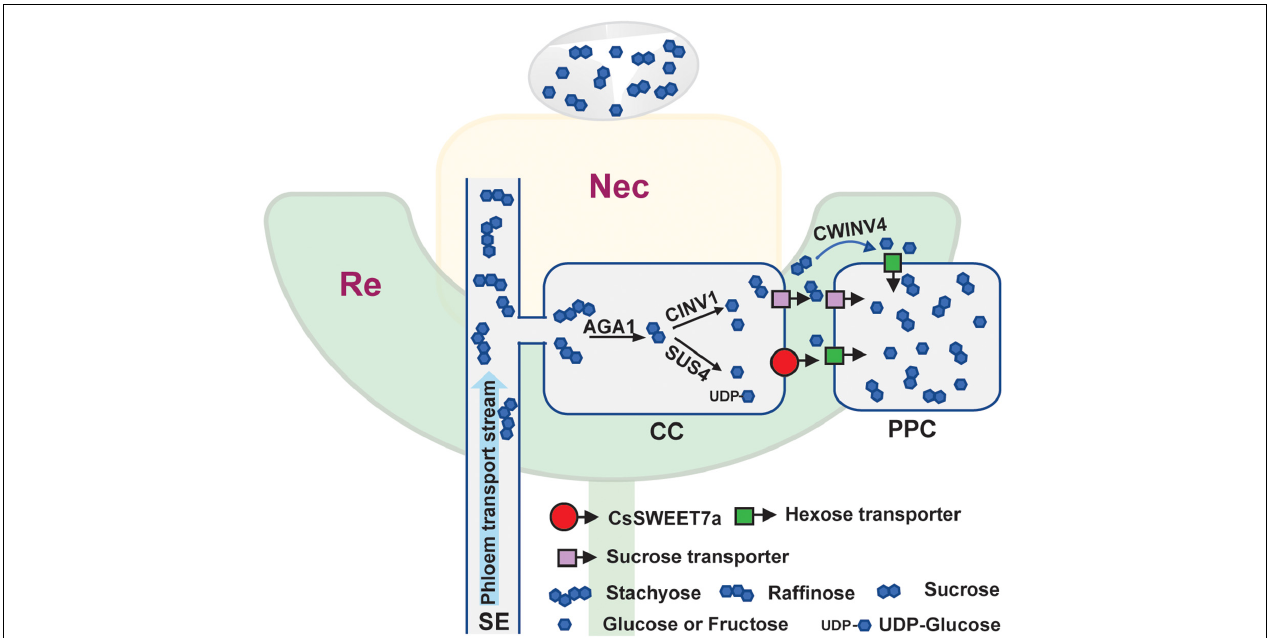
FIGURE 7 | Simplified model of CsSWEET7a function during phloem unloading in cucumber receptacle and nectary. The top light-yellow color region indicates the nectary (Nec) tissue, and the bottom light-green color region is the receptacle (Re) tissue. The droplet above the nectary represents the secreted nectar. A similar phloem unloading process is proposed in receptacle and nectary of male and female flowers. Photosynthetic sugars are transported to flower receptacles and nectary tissues via the phloem. As an RFOs-transporting plant, the majority of sugar in the cucumber phloem transport stream [in sieve element (SE)] is stachyose and raffinose, with a small amount of sucrose detected. The stachyose and raffinose could be broken down by α -galactosidase 1 (AGA1) to sucrose, which has three possible routes to phloem parenchyma cell (PPC): (1) sucrose is hydrolyzed by sucrose synthase 4 (SUS4) and/or cytosol invertase 1 (CINV1) to hexoses in companion cell (CC), and the resulting hexoses are exported to apoplasmic space by hexose transporter, e.g., CsSWEET7a or other SWEETs (Clade I/II which transport hexoses), before loading into PPC by hexose transporter; (2) sucrose is exported from CC to apoplasmic space by sucrose transporter, followed by hydrolyzation via CWINV4 to hexoses, and hexoses are taken up to PPC by hexose transporter; (3) sucrose is exported to apoplasmic space by sucrose transporter and is taken up by sucrose transporter to